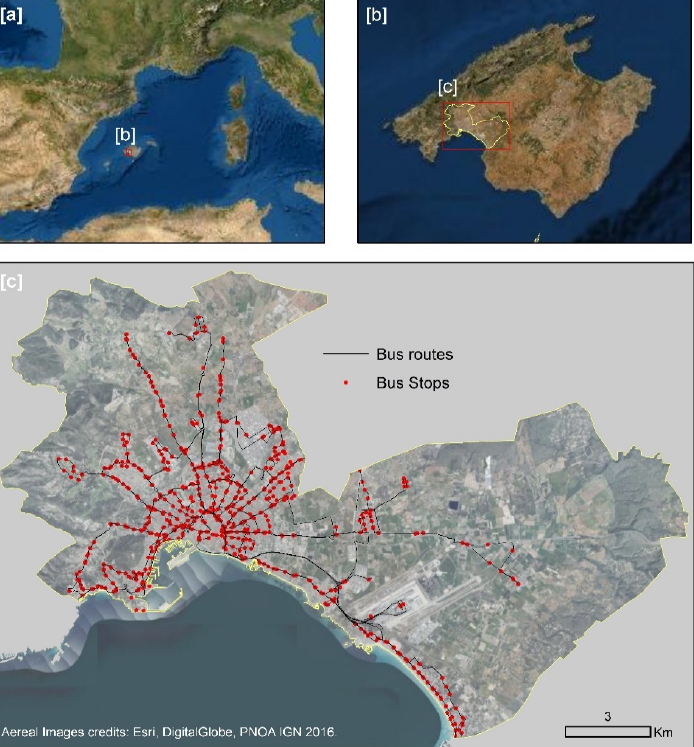
Figure 1. ( a ) Location of Palma municipality in the Mediterranean basin; ( b ) Location of Palma municipality on Mallorca island; and ( c ) Bus stops and bus lines of the public network [50].